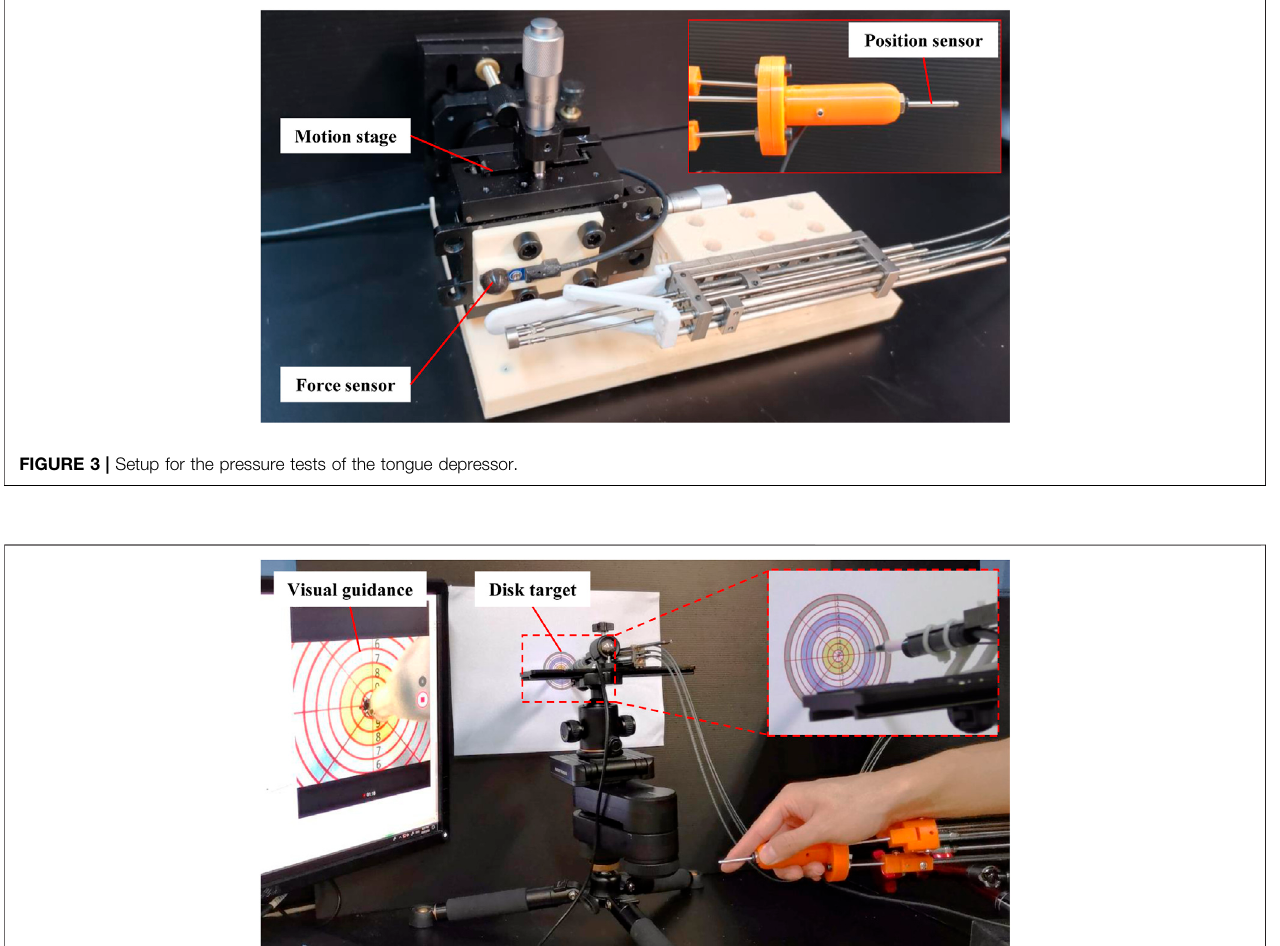
Frontiers in Robotics and AI |